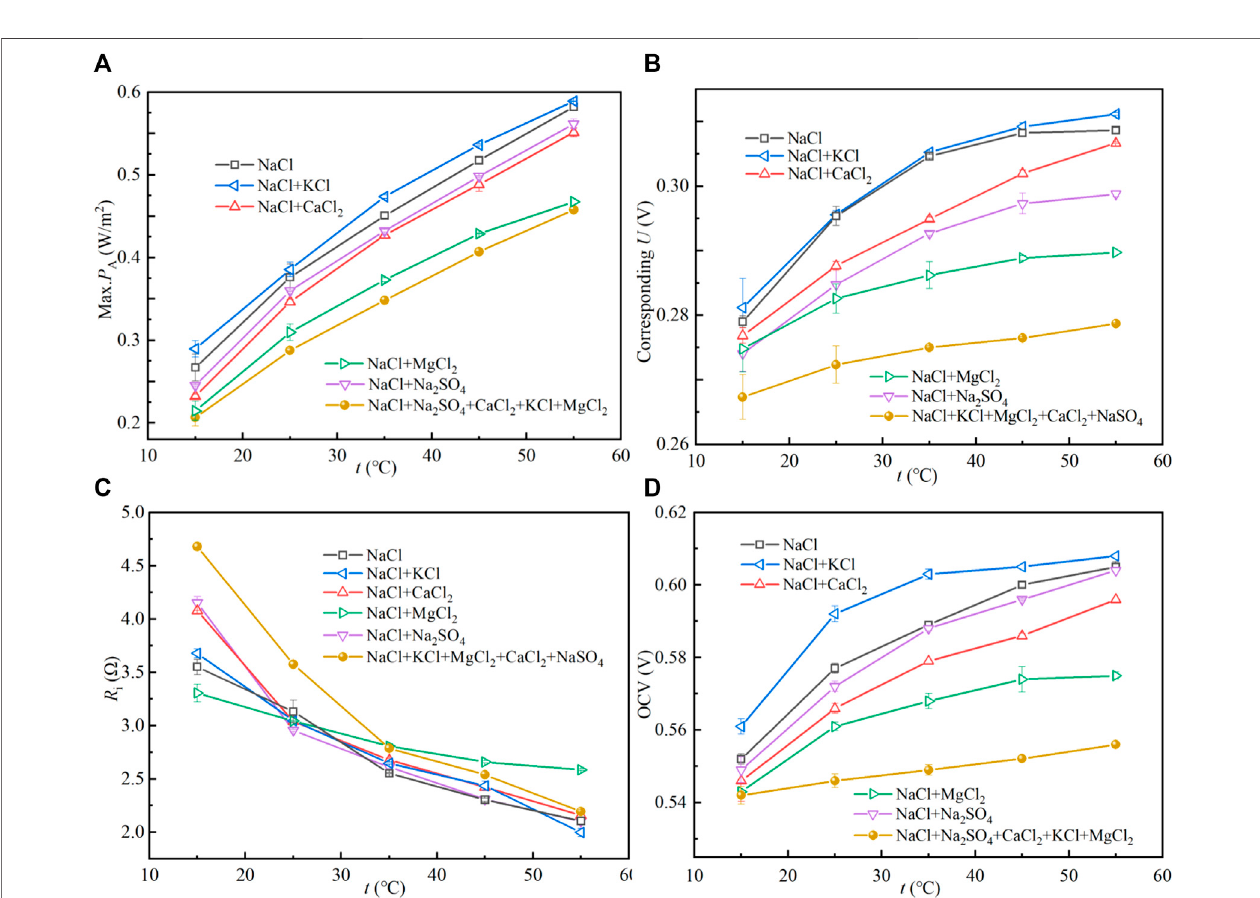
FIGURE 5 | Performance variation of the RED stack with the feed temperature. Flow rate is 50 ml/min, and concentrations of trace ions are the same as that in Figure 2 .